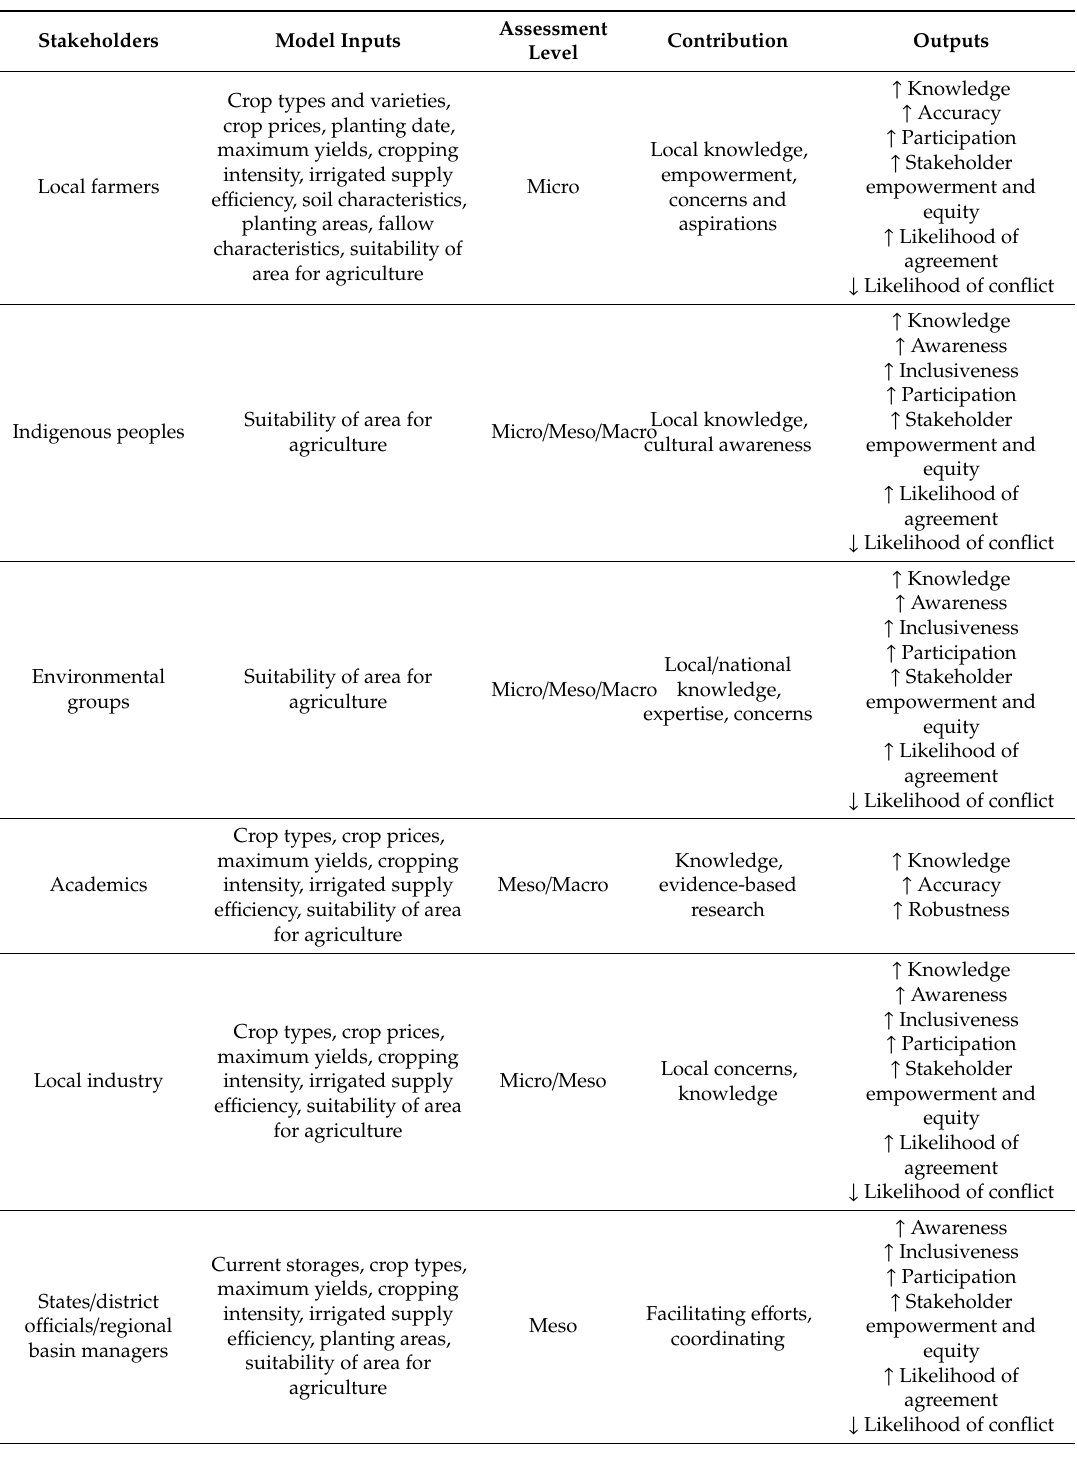
Table 1. Stakeholder model inputs, contributions and outputs at various assessment levels within the Purari Basin. Directions of arrows indicate increases ( ↑ ) and decreases ( ↓ ) of